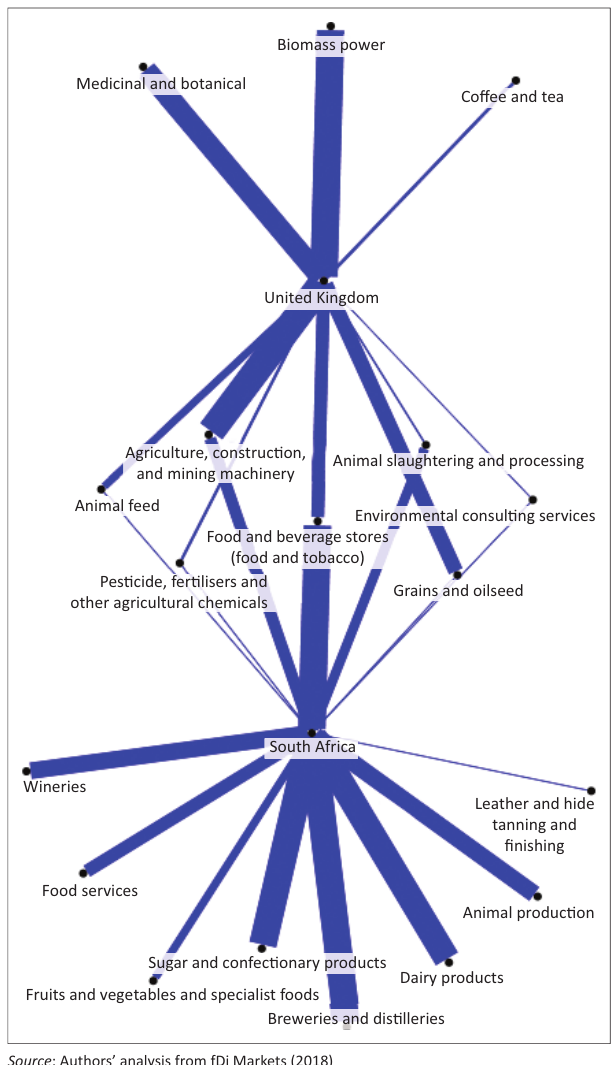
FIGURE 3: Foreign direct investment linkages in agriculture between the United States and South Africa versus South Africa and